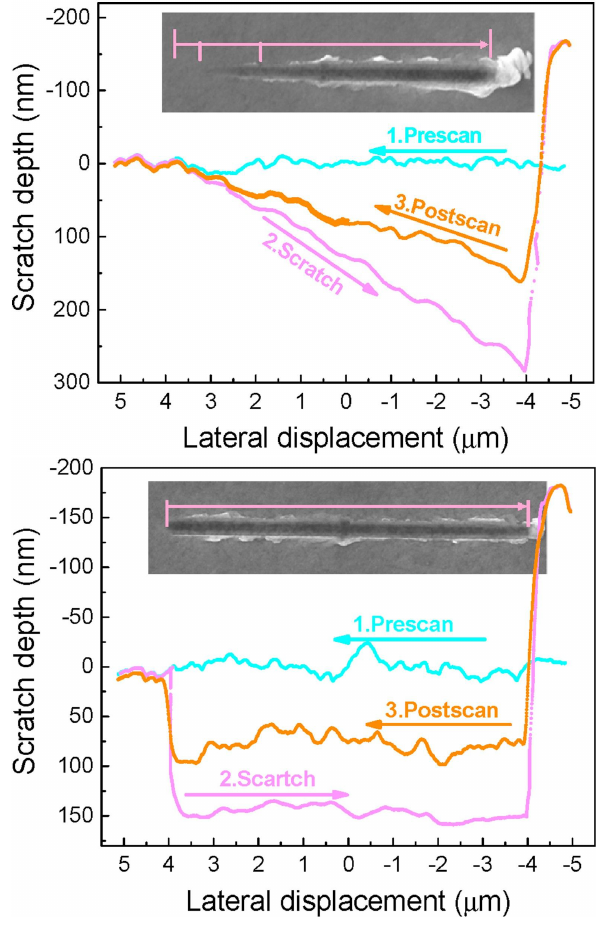
Figure 4: Nanoscratch test results on copper surfaces [47]: (a) Schematic diagram of the ramped load; (b) schematic diagram of the constant